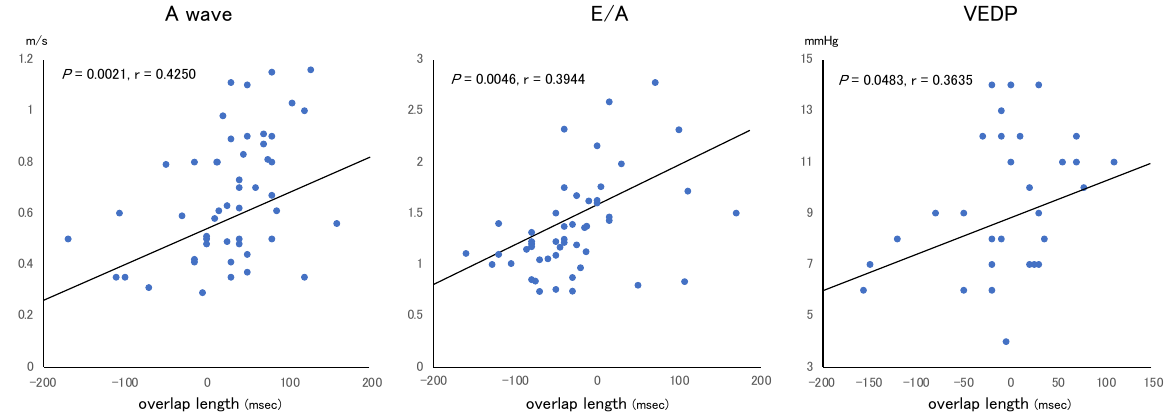
Figure 3. Positive correlations between overlap length and each parameter. VEDP, ventricular end-diastolic pressure.